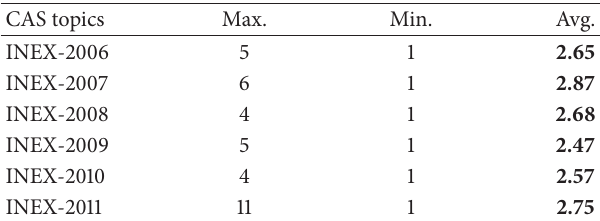
Table 1: Report for structure in CAS topics of